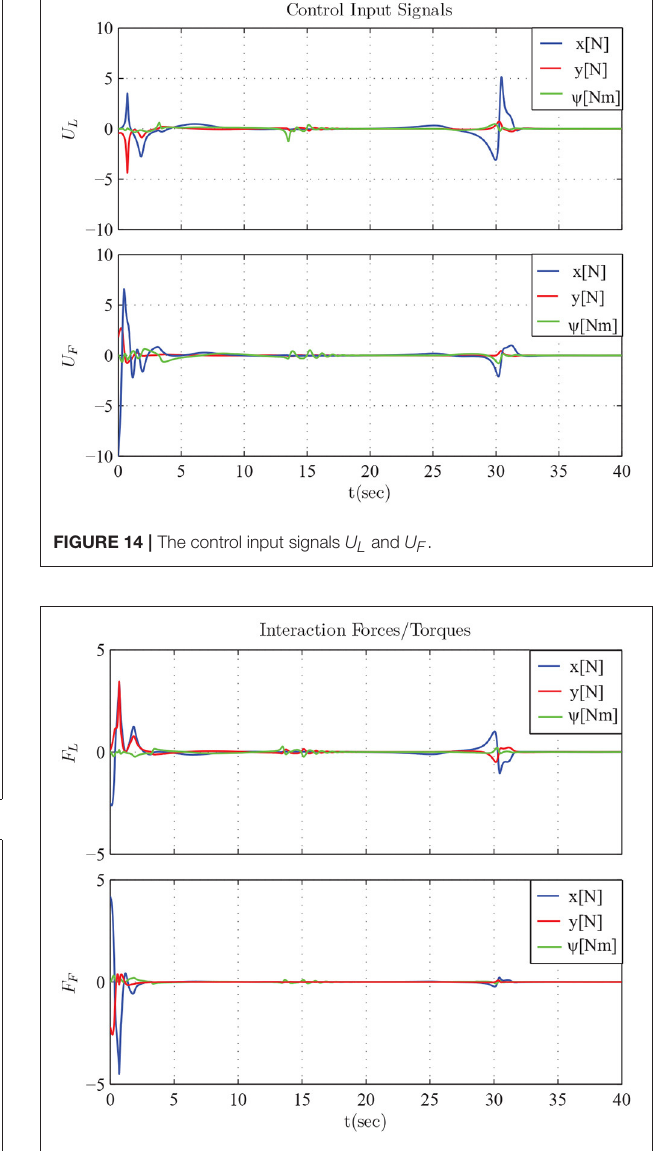
FIGURE 15 | The interaction forces F L and F F exerted between the object and the